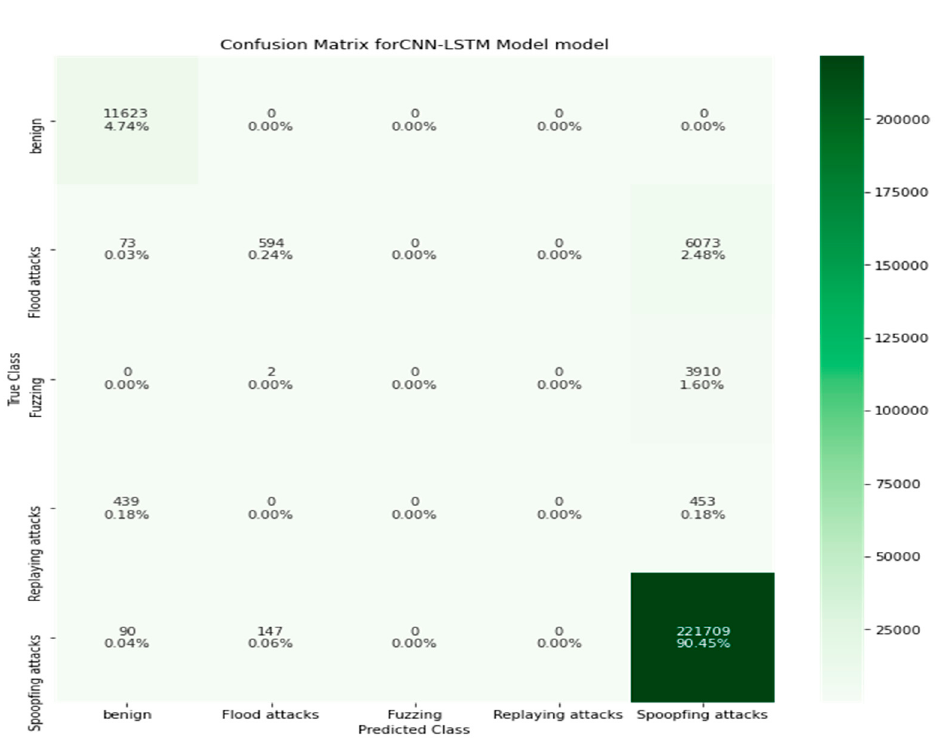
Table 9. Results of the CNN-LSTM model in the detection of all attacks on the dataset of a CAN bus. Attacks Precision % Recall % F1-Score % Benign 95 100 97 Flood 91 0.09 0.16 Replaying 0.0 0.0 0.0 Spoofing 0.0 0.0 0.0 95.44% 95.44% Weighted average 93 0.20 Loss 0.20